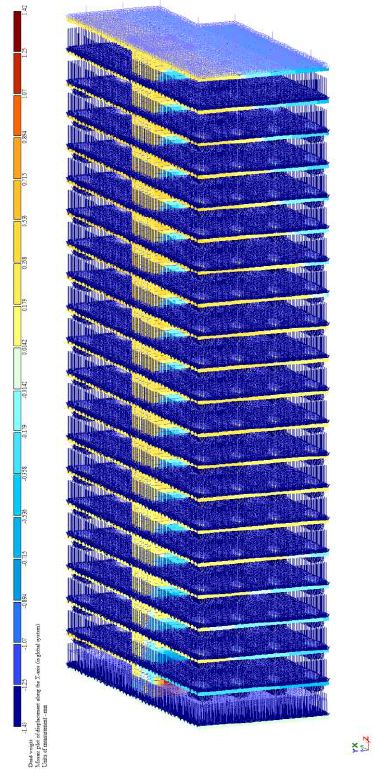
Figure 10 . Displacement field along the Y axis in mm. The meshed model for the considered building is given in Fig.